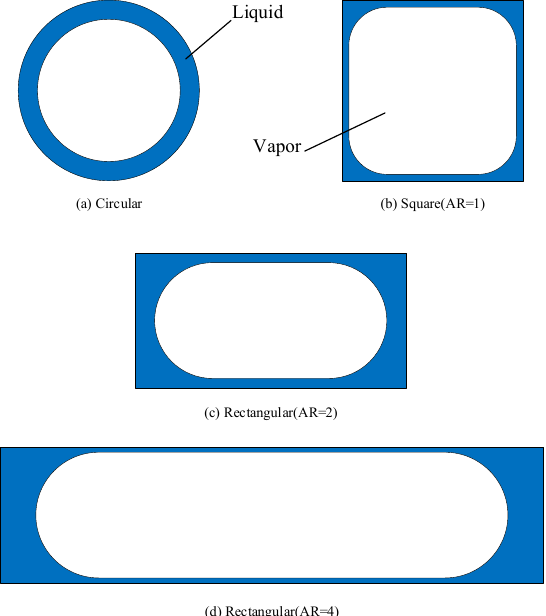
Figure 4. The distribution of the liquid film in microchannels with different cross sections (adapted from Ref. [46]).